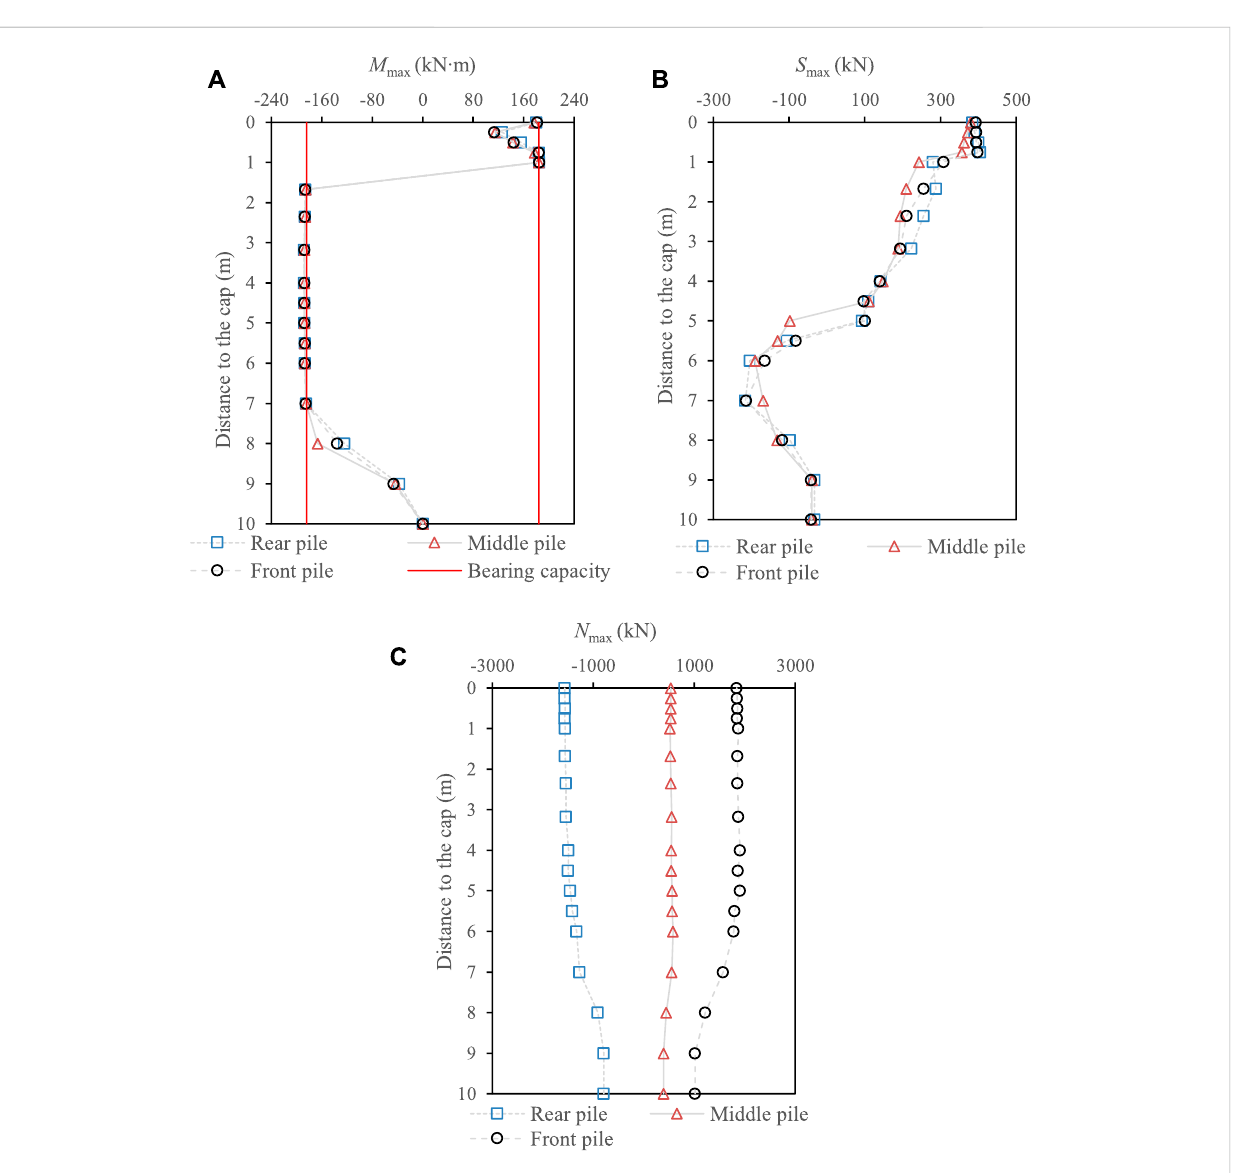
FIGURE 13 Distribution of the maximum internal force of a single pile at different rows (i.e., front, middle, and rear) (A) bending moment ( M max ), (B) shear force ( S max ), and (C) axial force ( N max ) (Case